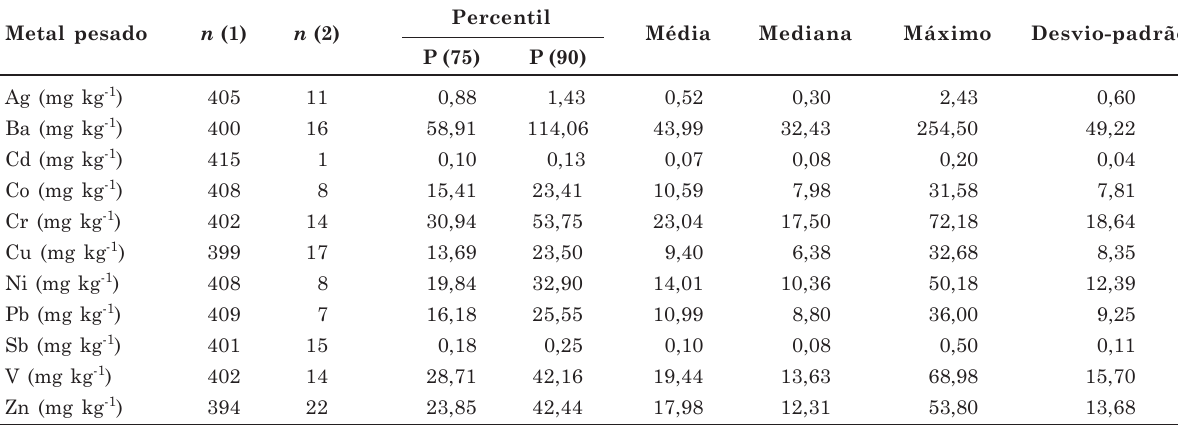
Quadro 3. Valores de referência de qualidade para metais pesados em solos do Estado do Rio Grande do